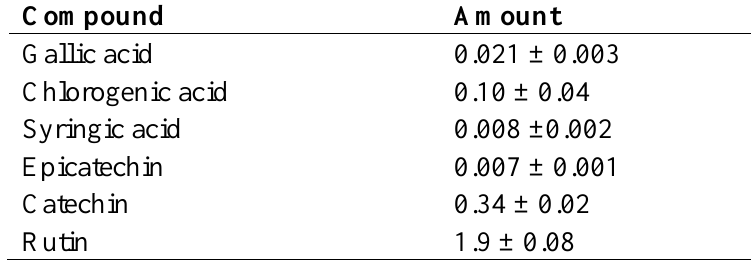
Table 1. Content (mg per g syrup) of various phenolics in fig syrup (means ± SD are